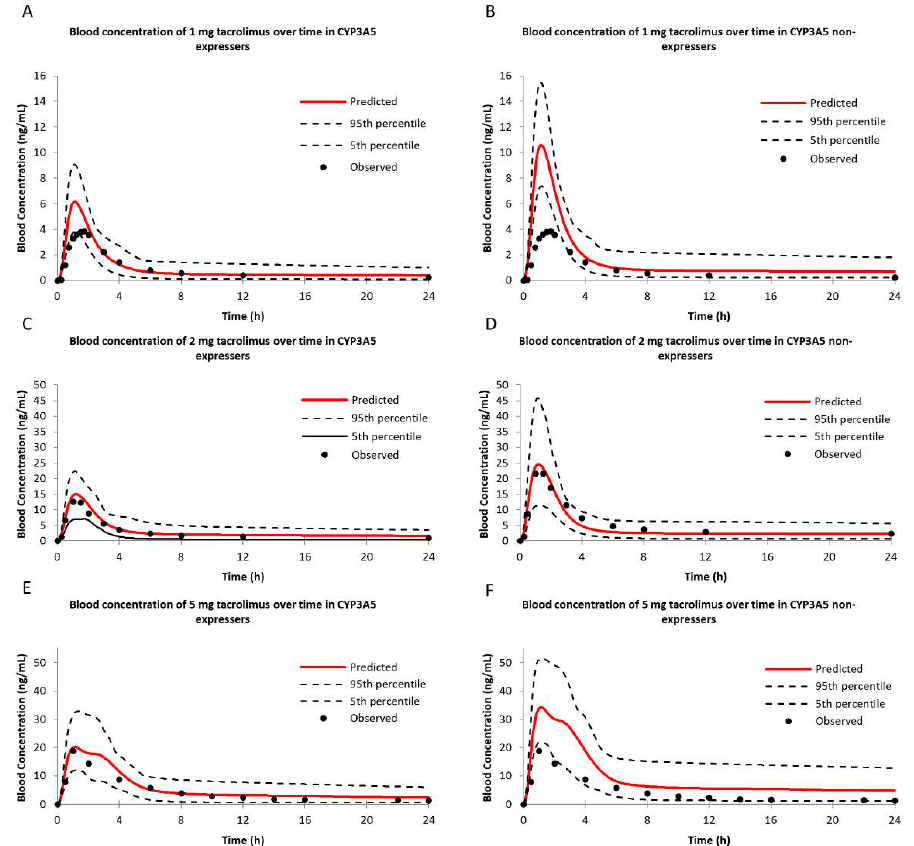
Figure 5. Simulations of blood concentration–time profiles of tacrolimus following a single oral dose of 1 mg ( A , B ), 2 mg ( C , D ) and 5 mg ( E , F ) dose in healthy CYP3A5 expressers and non-expressers by Simcyp ® . Dashed lines represent the 5th and 95th percentiles of each simulation. Table 1. Simulation results of tacrolimus with different doses.